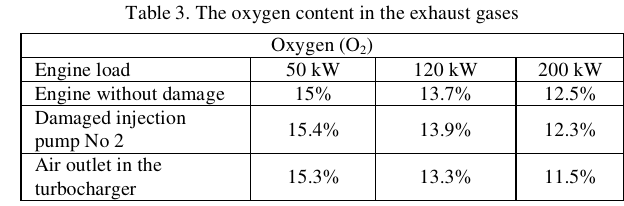
Table 3. The oxygen content in the exhaust gases